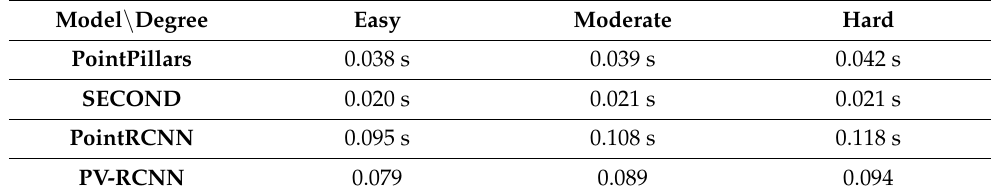
Table 5. Detection time.